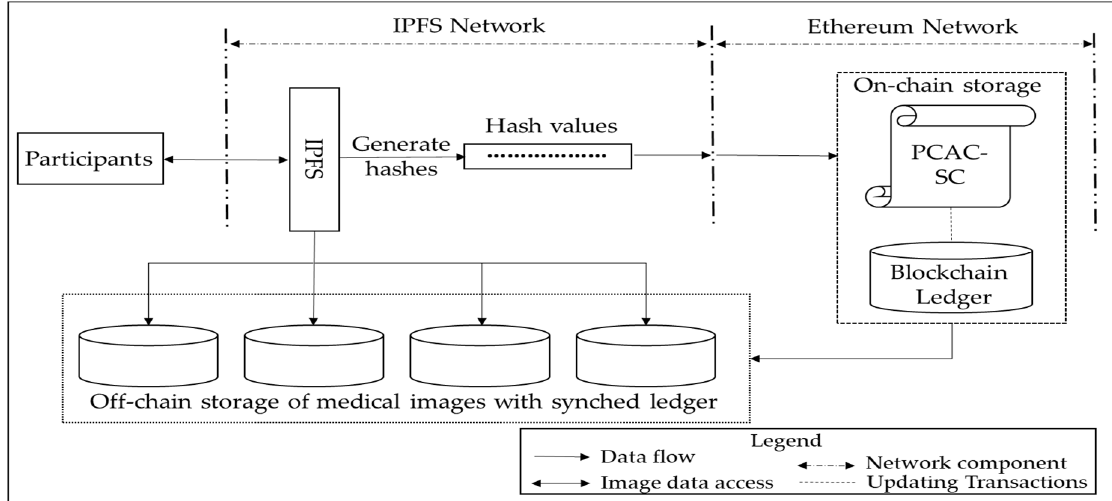
Figure 2. Architecture of patient-centric image management (PCIM) system. The architecture component split into two main decentralized modules: IPFS and Ethereum network.